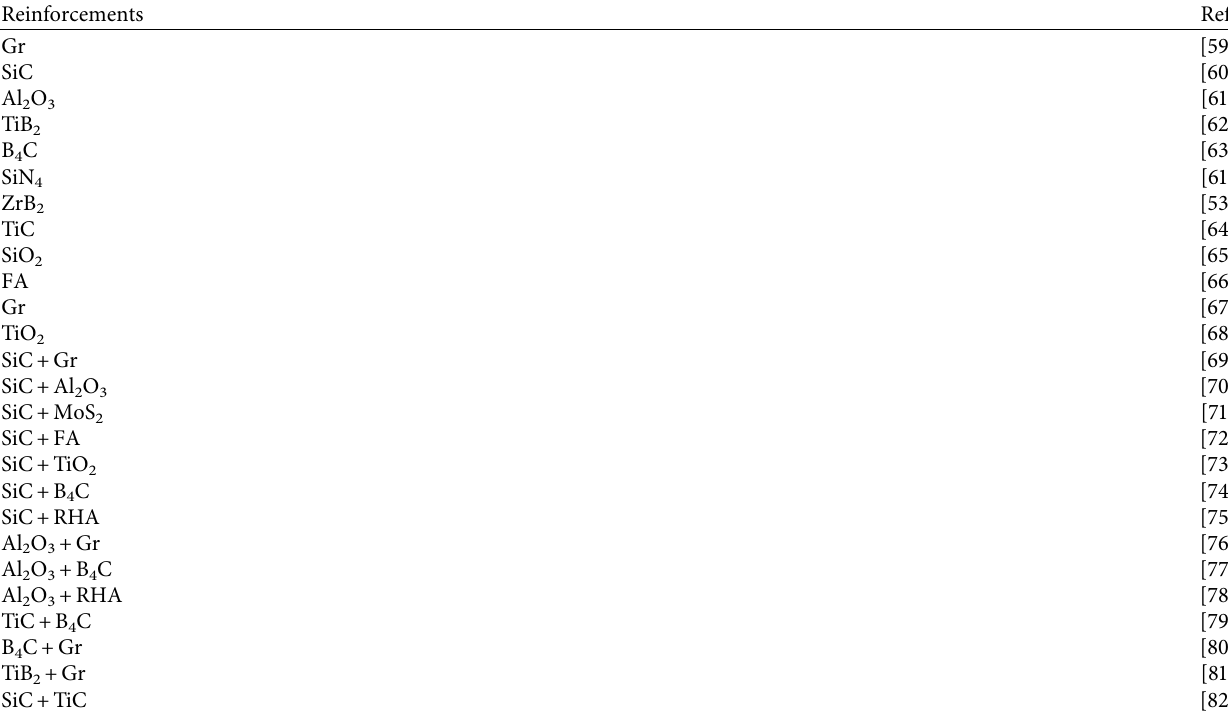
Table 6: Various reinforcement materials used in Al-MMCs.